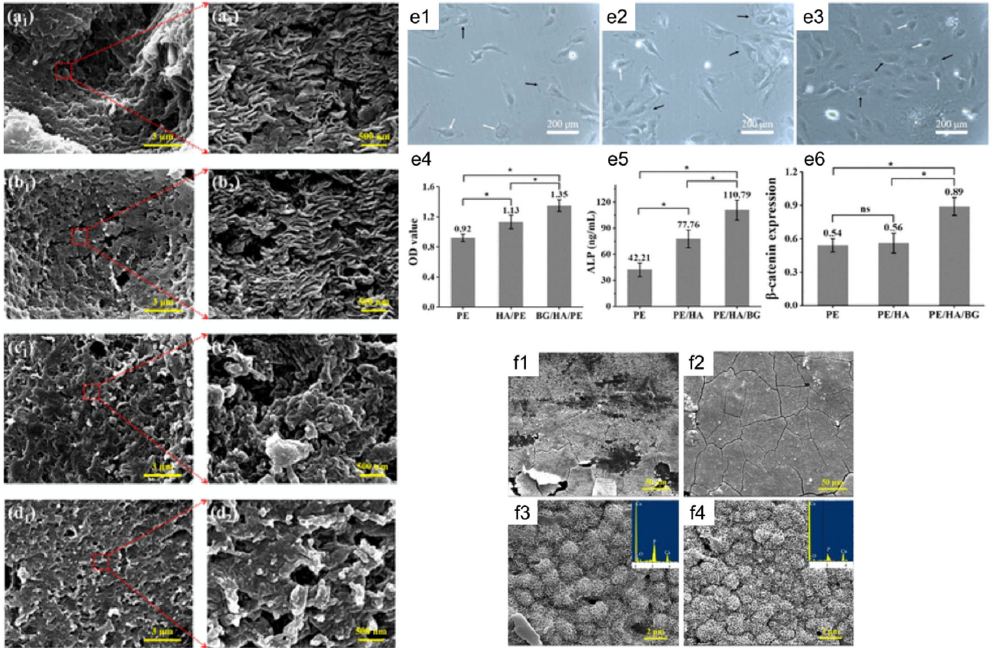
Figure 14. Bone substitute formed by structuring injection molding. FE ‐ SEM images showing crystalline morphology of ( a1 , a2 ) structured HA/PE, ( b1 , b2 ) structured BG/HA/PE, ( c1 , c2 ) normal HA/PE, and ( d1 , d2 ) normal BG/HA/PE. MC3T3 ‐ E1cells adhesion and spreading on ( e1 ) structured PE, ( e2 ) structured HA/PE, and ( e3 ) structured BG/HA/PE after culturing for 7 days. ( e4 ) CCK ‐ 8 results, ( e5 ) ALP results and ( e6 ) Western blot analysis. The intensities of each test protein bands in (f) were normalized. SEM images of the surface of ( f1 , f3 ) structured HA/PE and ( f2 , f4 ) structured BG/HA/PE after immersion in SBF for 21 days: magnification of ( f1 , f2 ) 1000× and ( f3 , f4 ) 10 000×. The insets of c and d are the EDX spectrum of the sample surface. Reprinted with permission from Ref.